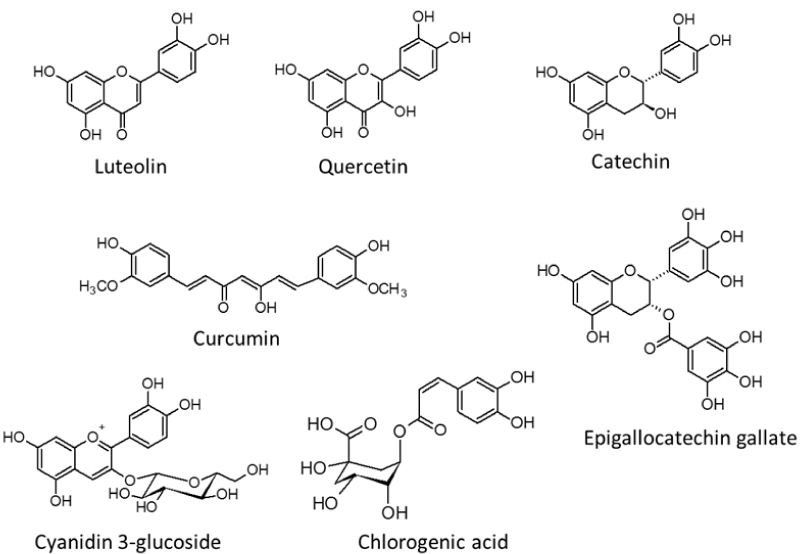
Figure 3. Chemical structures of polyphenols which have been reported to inhibit